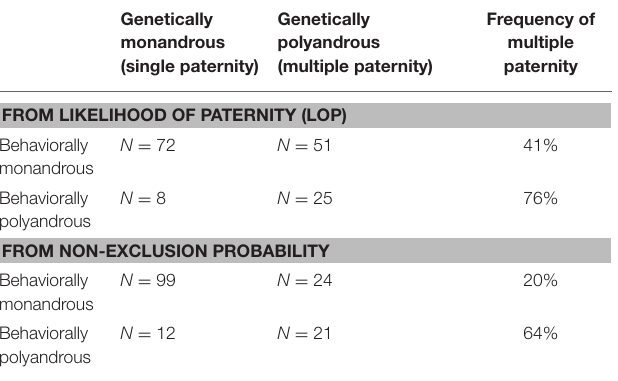
males had the highest LOP for 68% of the offspring